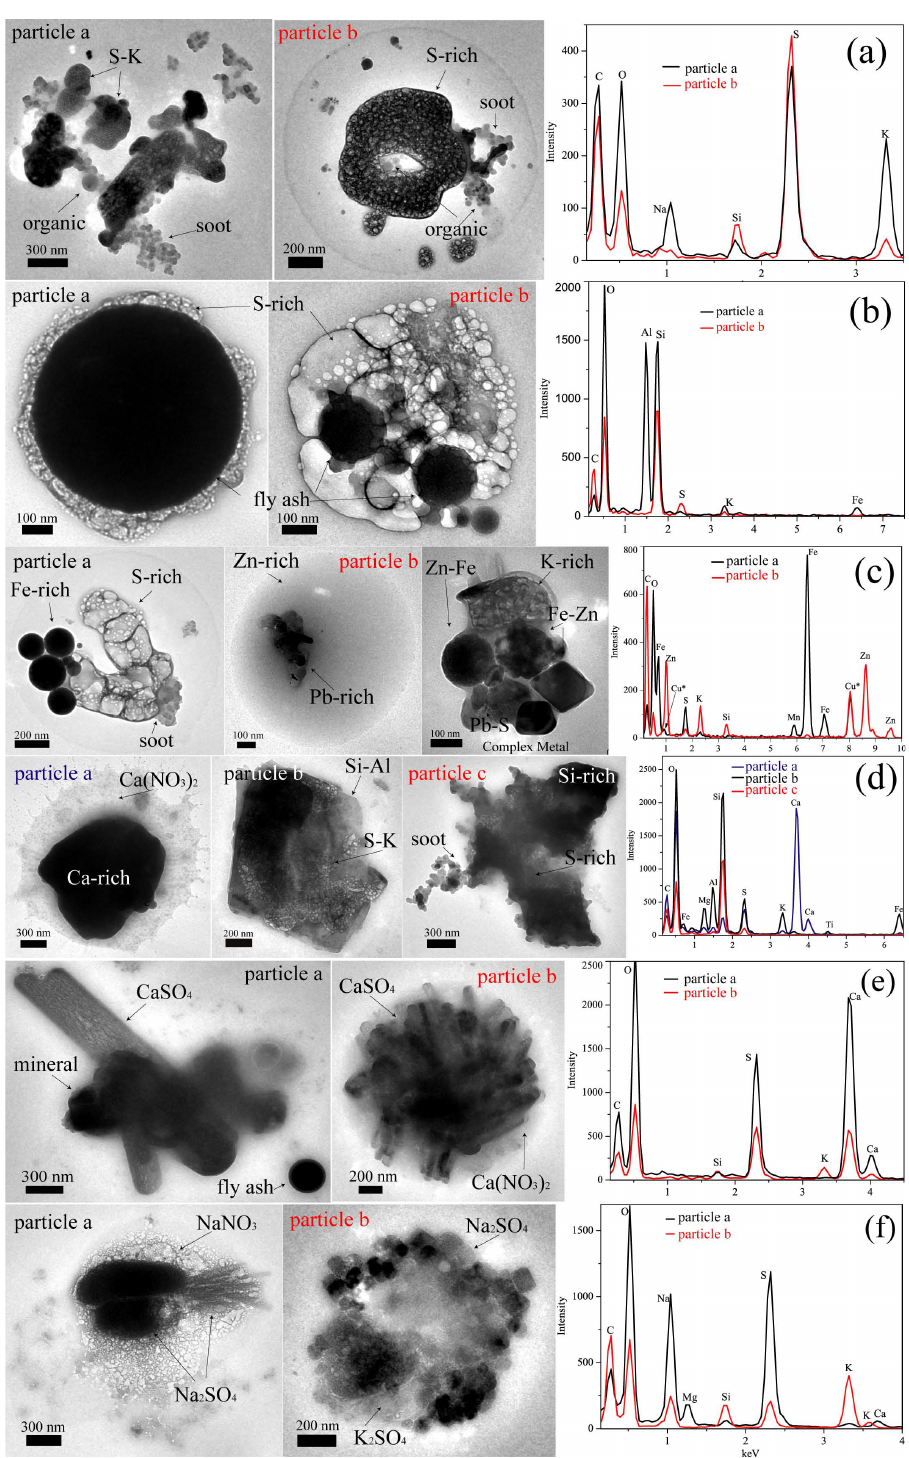
Fig. 4. TEM images of different individual aerosol particles and their corresponding EDS spectra. (a) S-rich particles (particle a–b) mainly contain S with a certain amount of K, Na. Most S-rich particles contain organic matter and soot. (b) Fly ash particles (particle a–b) contain Si and/or Al with minor Fe, Mn, and Ti. (c) Metal particles (particle a–b) are Fe-rich, Zn-Pb, Zn-Fe, or their mixtures. (d) Crustal mineral particles (particle a-c) have complex compositions, which depend on mineral types. (e) Ca-S/N particles (particle a–b) are CaSO 4 , Ca(NO 3 ) 2 , or their mixtures. (f) Na/K-S/N particles (particle a–b) mostly are NaNO 3 , Na 2 SO 4 , KNO 3 , K 2 SO 4 , or their